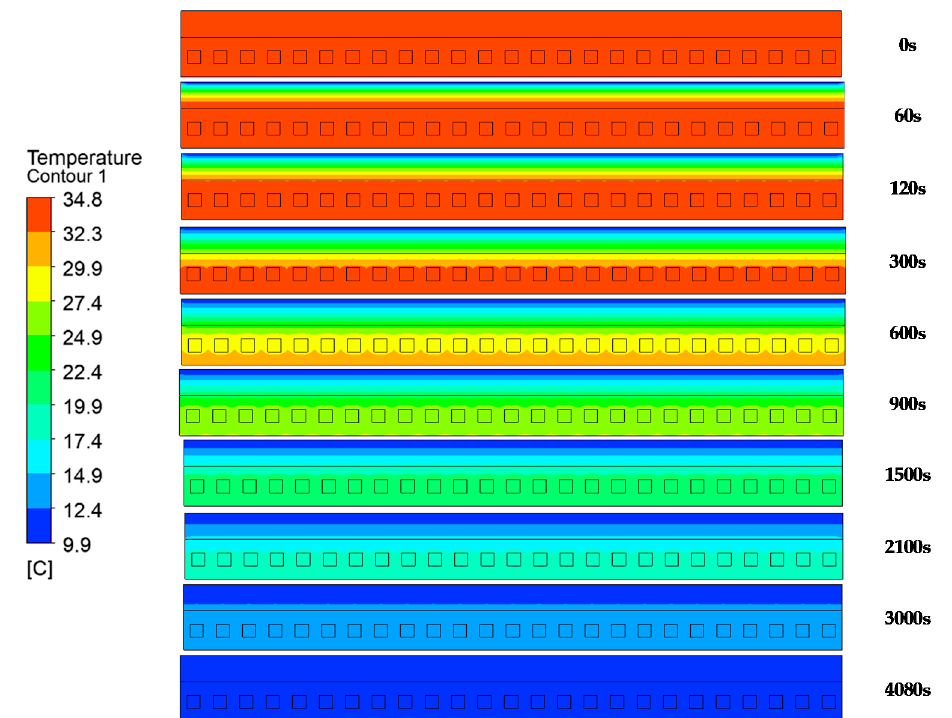
Figure 6. A section through the HPHS during the cooling phase.